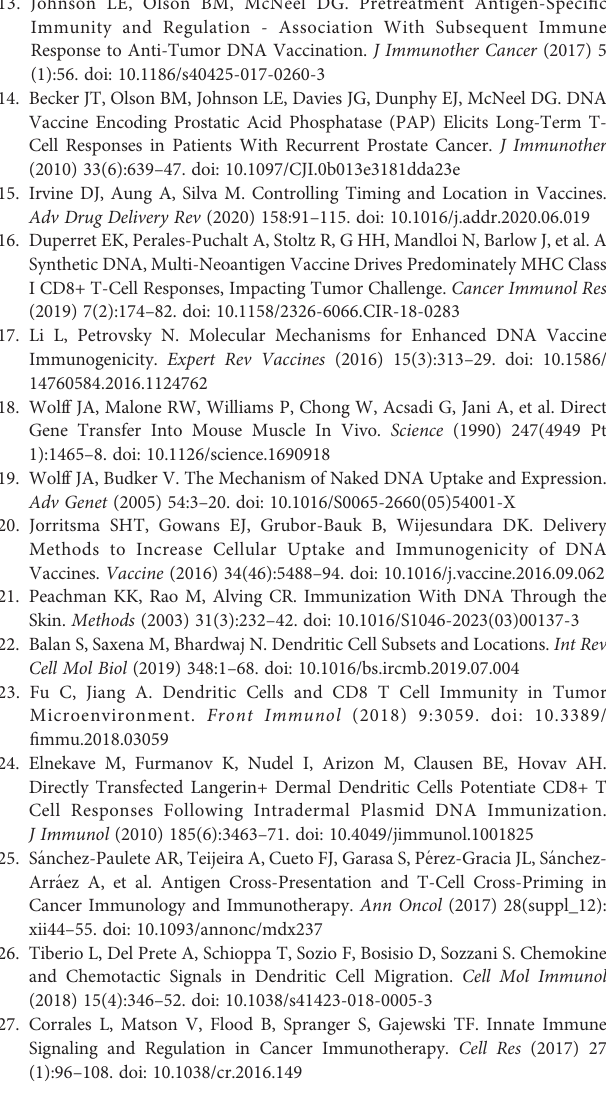
Supplementary Figure 1 | Immune response induced by the DNA vaccine under the normal vaccination strategy depends on the vaccine dosage. (A) Immunization regimen. Twenty BALB/c mice were divided into four groups (n=5). DNA vaccine doses included 25, 50, and 100 m g in the respective groups. Vaccines were administered intramuscularly three times at two-week intervals. Recombinant adenovirus (rAd) (1×10 8 pfu in 100 m l per mouse) was administered two weeks after administration of the last DNA vaccine dose (B) ELISpot assay. Ten days after rAd vaccination, all mice were sacri fi ced to perform the ELISpot assay. Splenocytes were incubated with hSurvivin peptide (H2-K d sequence: AFLSVKKQF, fi nal concentration: 10 µg/mL) and hMUC1 peptide (H2-K d sequence: APDTRPAPG, fi nal concentration: 10 µg/mL), and the secretion of IFN- g per million splenocytes (ELISpot assay) was determined. (n.s. p > 0.05, *p < 0.05, **p < 0.01, ***p <